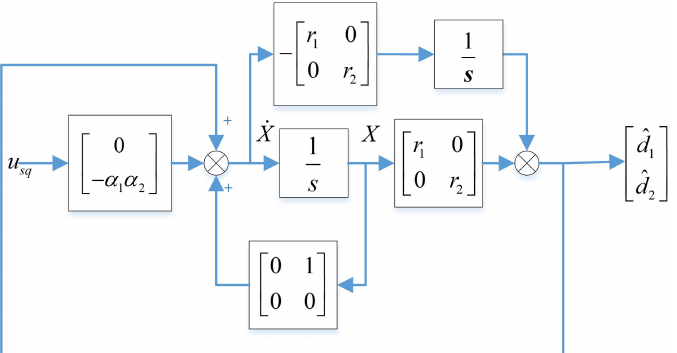
Figure 3. The structure of the non-linear disturbance observer.